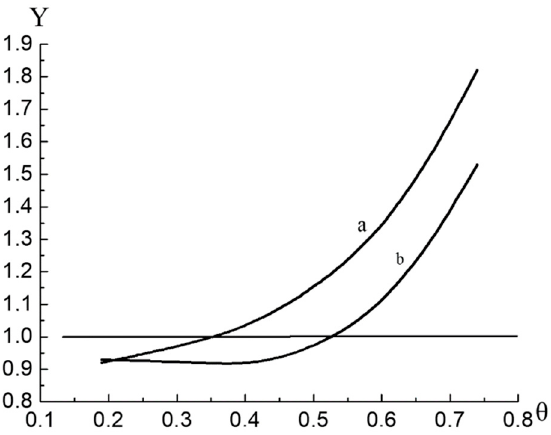
Figure 3. Results of analysis for sample 2 with Equation (33). (a) Equation (27); (b) Equation (31).